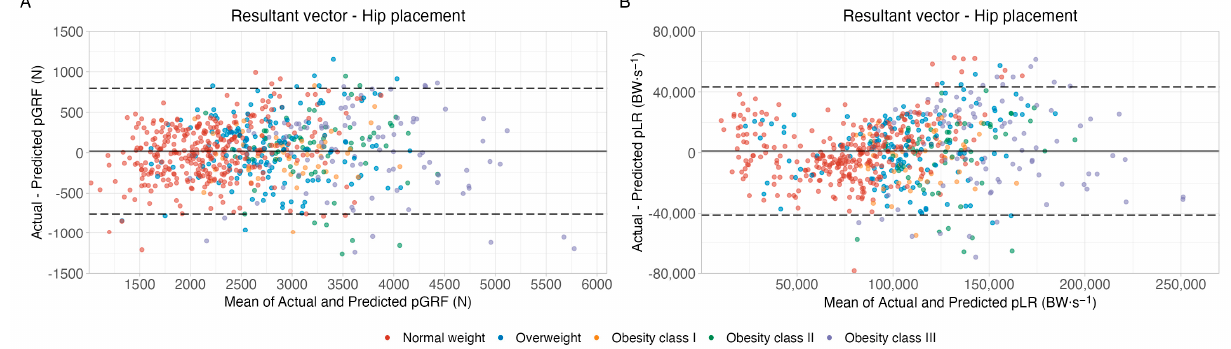
Figure 7. Bland–Altman plots showing agreement between actual and predicted peak ground reaction force (Panel A ) and loading rate (Panel B ) for the resultant vectors from hip-worn accelerometers. Continuous thick lines show bias (the average of the differences between actual and predicted values), while dashed lines show the limits of agreement (bias ± standard deviation). Abbreviations: pGRF, peak ground reaction force; pLR, peak loading rate.